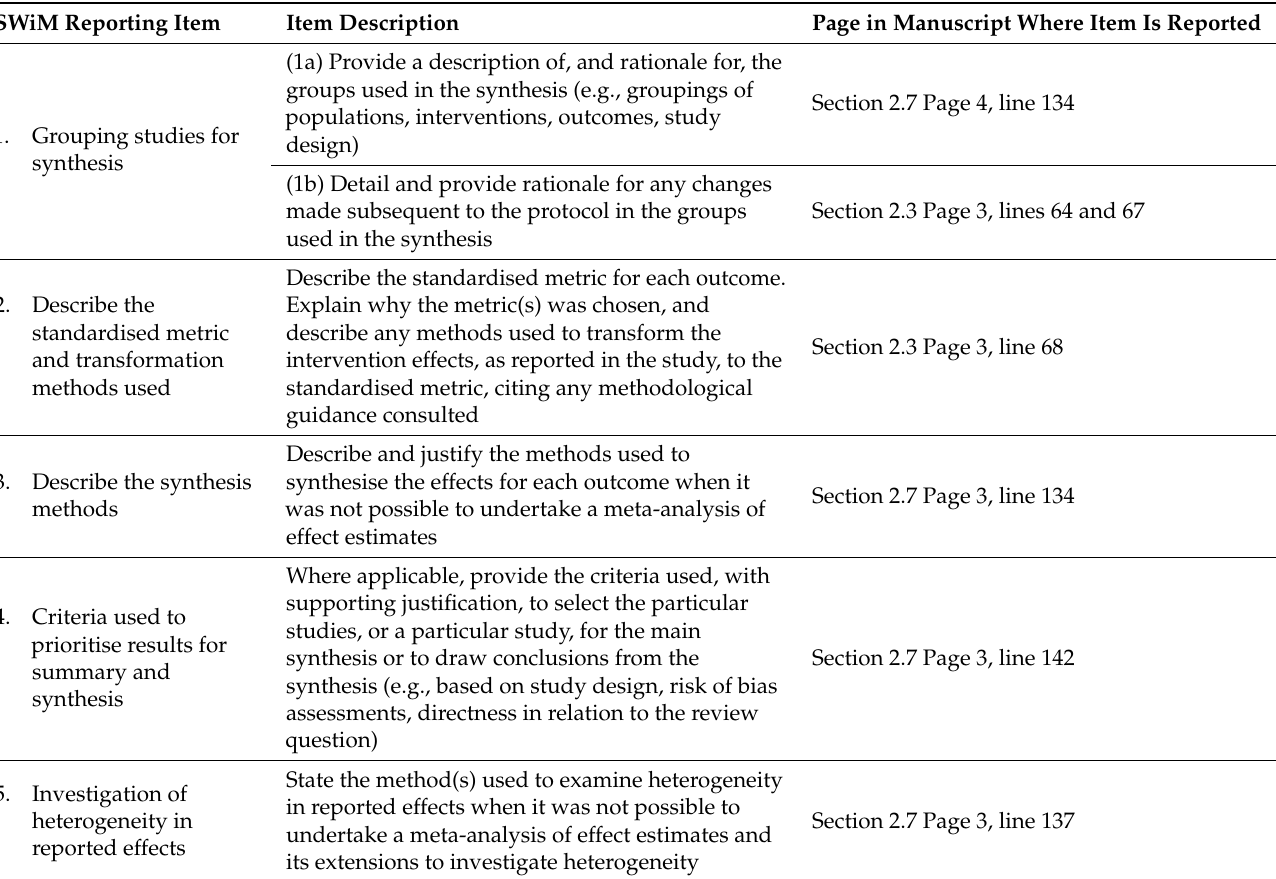
Table A2. Systematic Review Without Meta-analysis (SWIM) checklist